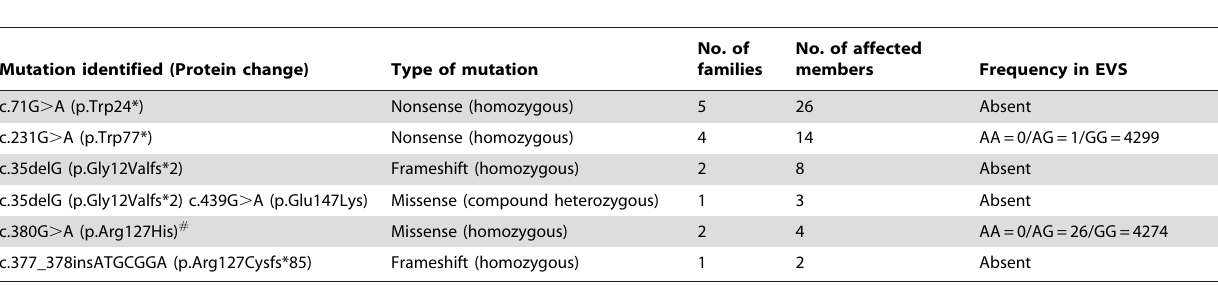
Table 1. Spectrum of recurrent GJB2 mutations in Pakistani families with autosomal recessive non-syndromic hearing loss